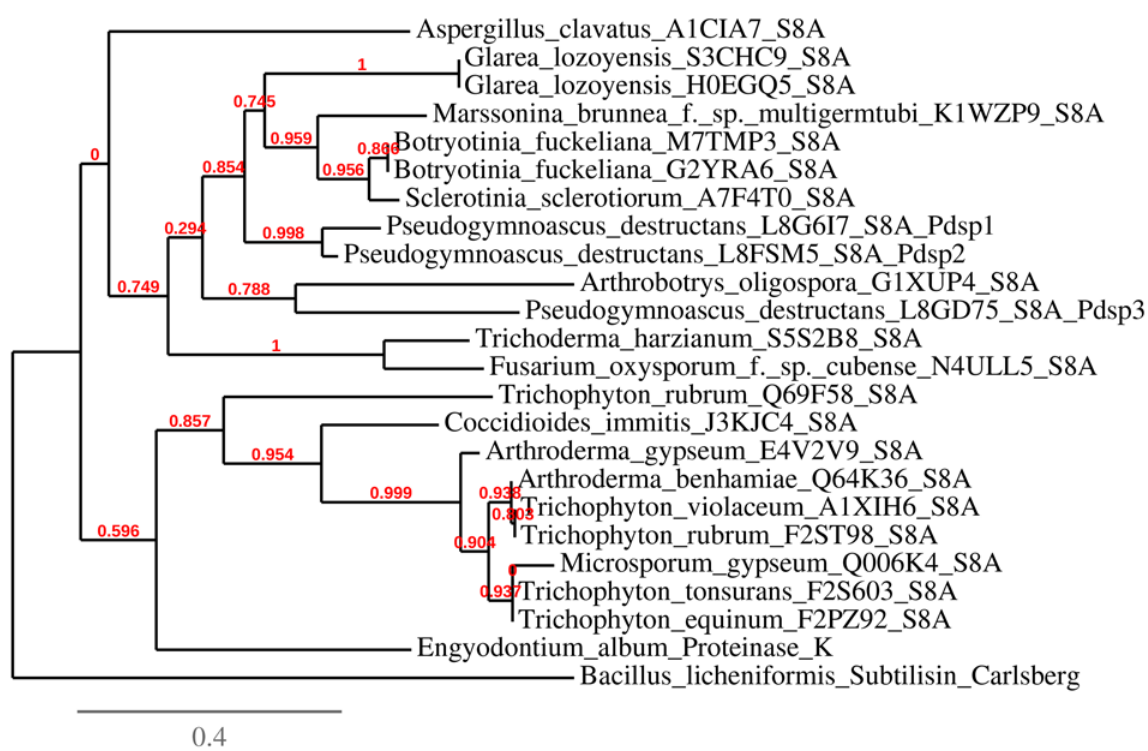
Fig 7. Phylogenetic tree generated from S8 serine proteases primary sequence from P . destructans and other select microbial organisms. Included are three serine proteases from P . destructans , selected serine protease sequences (S8A proteinase-K subfamily) from plant pathogenic and human dermatophytic fungi, proteinase K, Carlsberg subtilisin, and Aspergillus cavatus serine protease. Phylogenetic tree generated with program Phylogeny.fr (S8A accessions are listed in S1